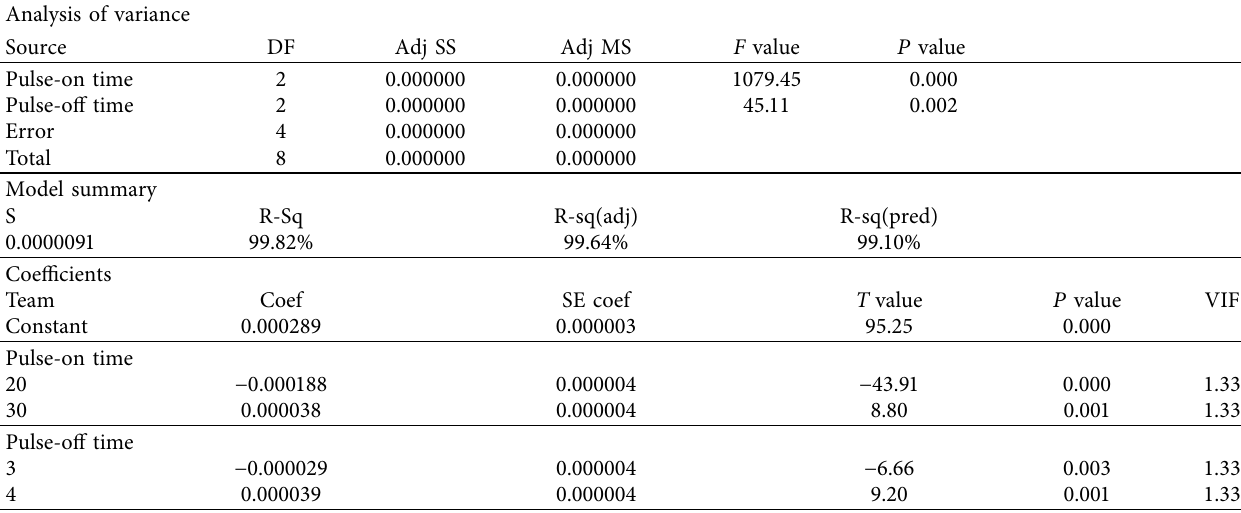
Table 18: ANOVA model for mild steel.